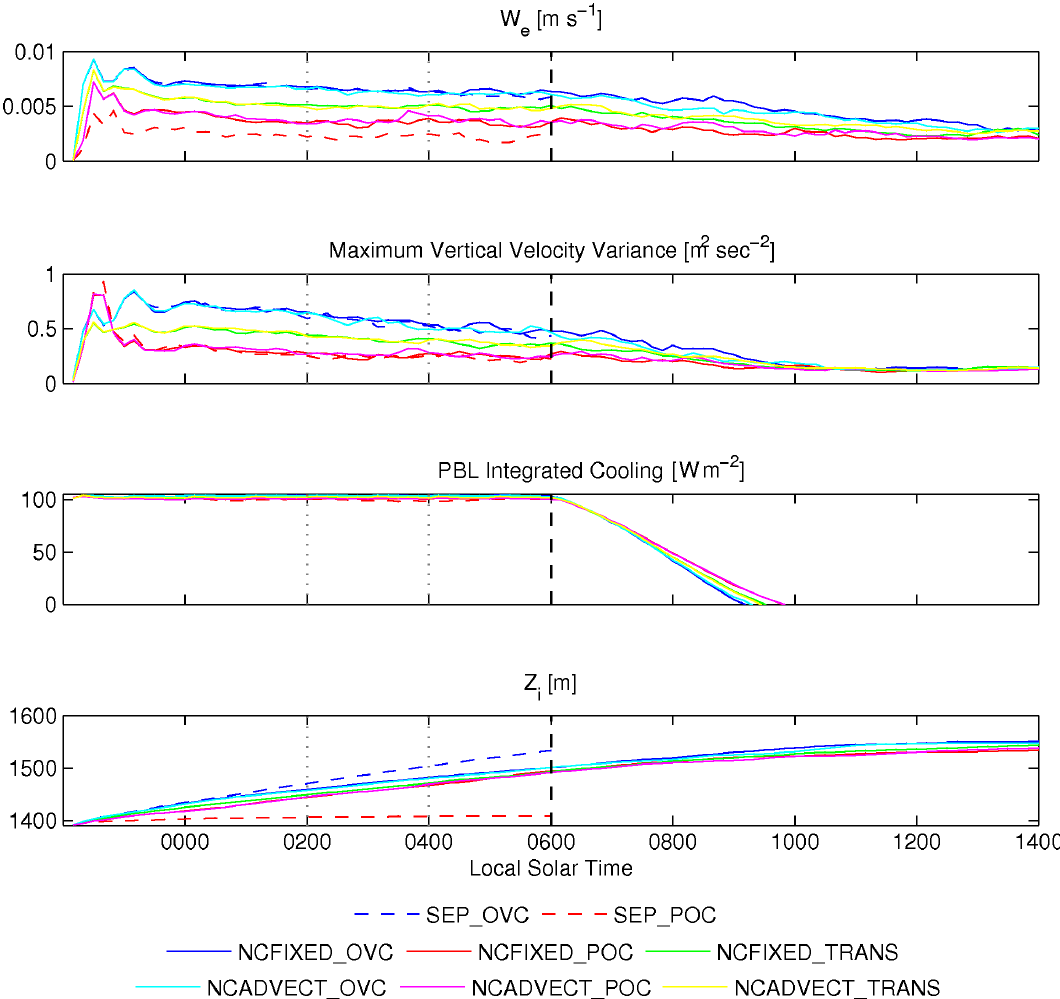
Fig. 13. Region averaged time series of entrainment-related quantities for all model runs. Sunrise is at 06:00 LST (vertical dashed line).